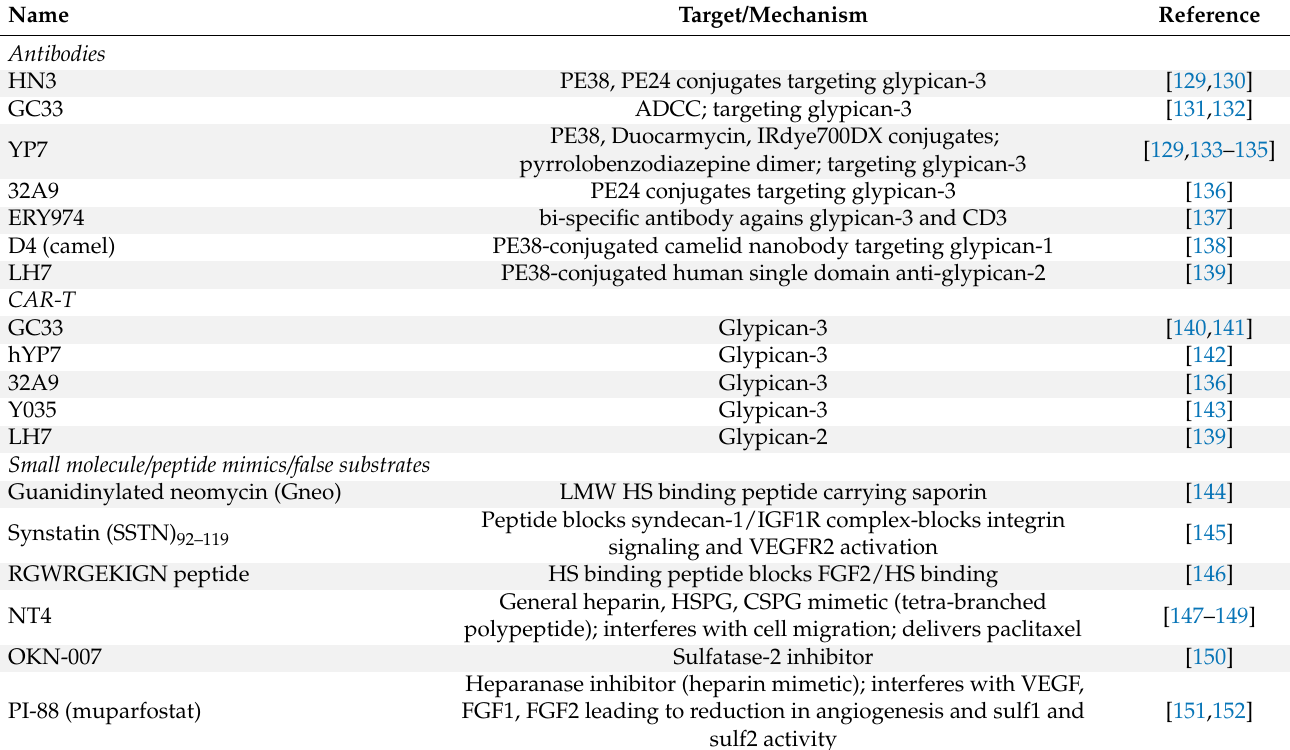
Table 2. Proteoglycan targeted tumor